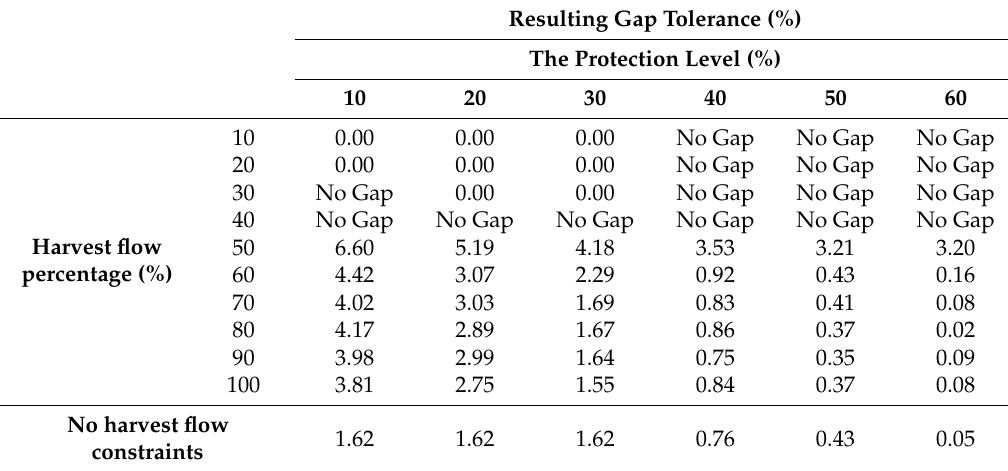
Table 3. The resulting gap tolerance for instances of the ROB